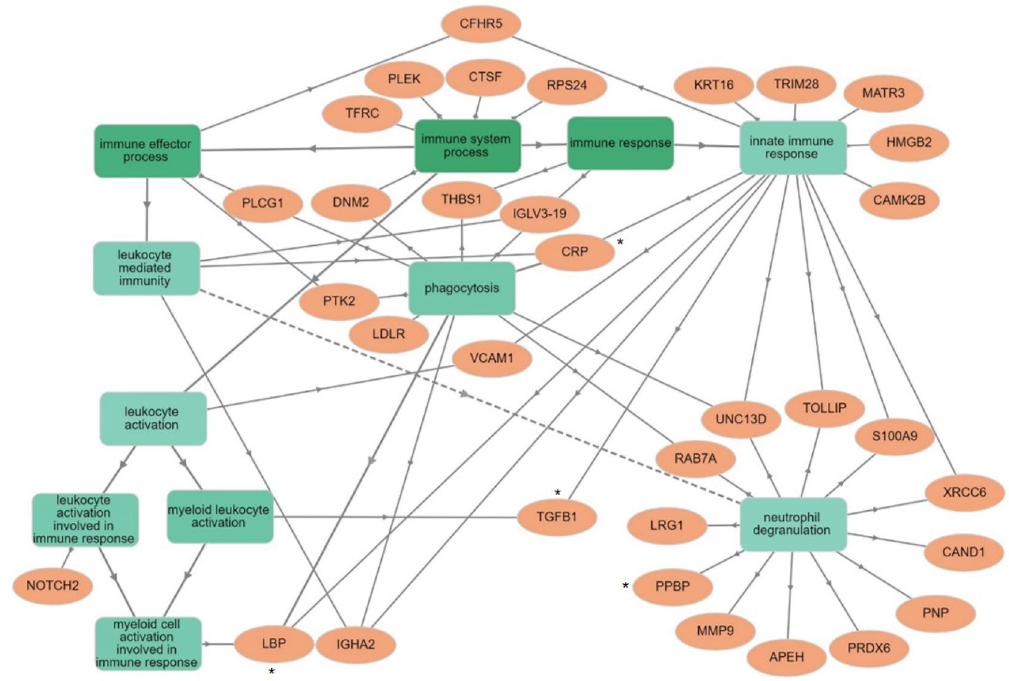
Figure 3. Visualisation of GO enrichment analysis for the top 70 most significantly upregulated proteins. There are two distinguishable types of nodes: GO term nodes (boxes) and genes (ellipse), when an edge connects two GO terms the arrow is directed from the less specific term to the more specific term. When an edge connects a GO term and a gene it is always directed towards the gene. GO term nodes are coloured by p value of enrichment the more significant the enrichment of the term (the smaller p value) the more intense the colour of the node. Genes colour has no